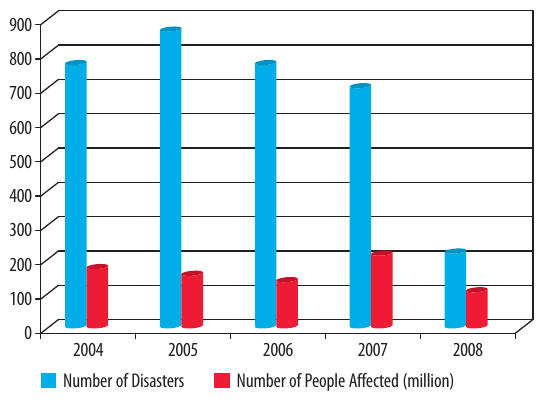
Figure 1. Number of disasters and people